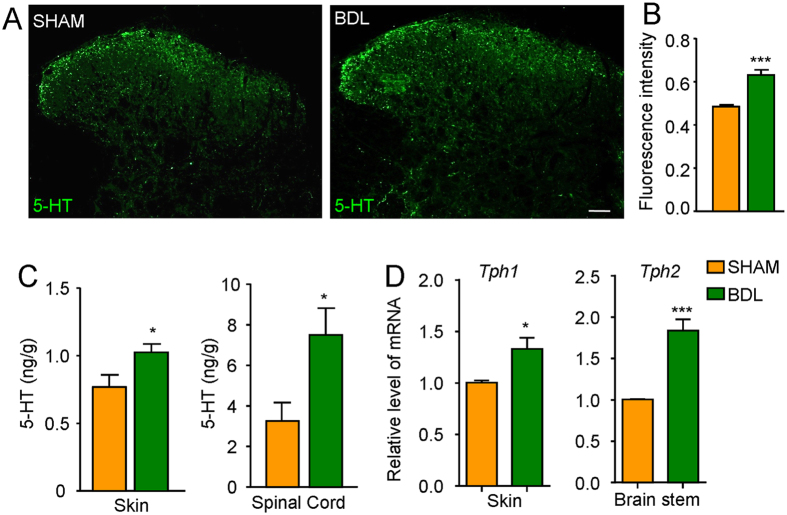
The 5-HT level in the skin and the spinal cord significantly increased in BDL rats.(A) Representative photomicrographs showing the immunostaining of 5-HT in spinal cord dorsal horn of the sham and BDL rats 15 days after BDL surgery. Scale bar: 100 μm. (B) The quantitative analysis showed that the 5-HT-positive immunofluoresence density significantly increased in spinal cord BDL rats compared to sham rats 15 days after BDL surgery (n = 4 per group). (C) HPLC analysis showed that 5-HT level in the skin and the spinal cord significantly increased in BDL rats compared to sham rats 15 days after BDL surgery (n = 5 per group). (D) qPCR analysis showed the mRNA expression of tryptophan hydroxylase 1 (Tph1) in the skin and tryptophan hydroxylase 1 (Tph2) in the brain stem, the rate-limiting enzymes for 5-HT synthesis, were up-regulated in BDL rats compared to sham rats. (*P < 0.05, ***P < 0.001 versus sham values and analyzed by Student’s t-test).